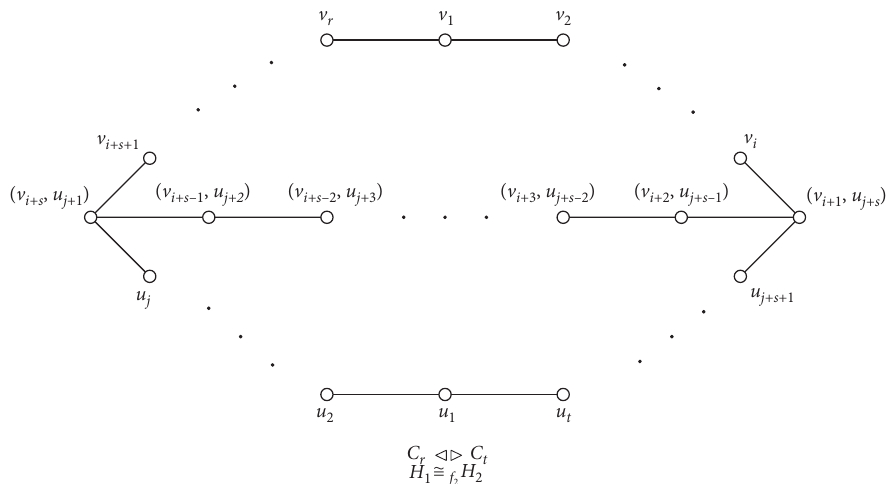
Figure 3: The amalgamation of C